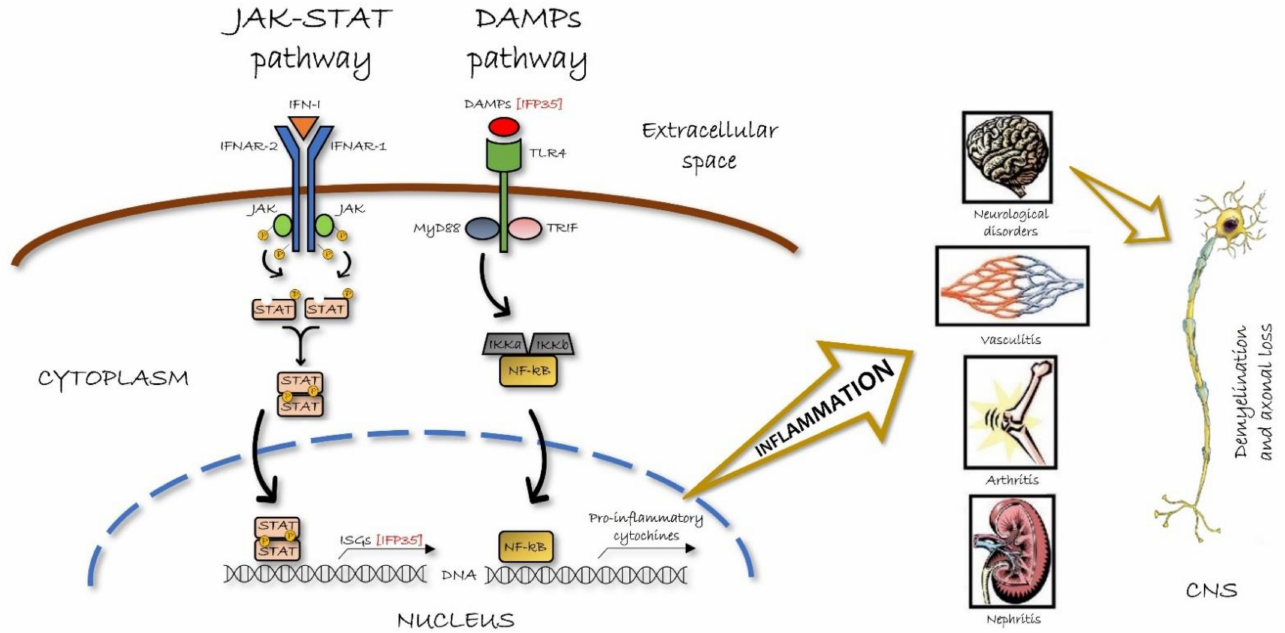
Figure 3. Mechanistic figure of JAK-STAT and DAMPs pathways involving IFP35. In the JAK-STAT pathway, the link between type I IFN molecule (IFN-I) and its receptor (IFNAR-1/IFNAR-2) induces the ligand-dependent dimerization of intracellular subunits, rapidly activating, in turn, the associated Janus kinase (JAK) by auto phosphorylation. Then, the activated dimer of signal transducer and activator of transcription (STAT) undergoes nuclear translocation, resulting in different interferon stimulated genes (ISGs) transcription, such as 35-kDa interferon-induced protein (IFP35). In the DAMPs pathway, the extracellular IFP35 serves as a damage associate molecular pattern (DAMP) molecule, recognized by Toll like receptor 4 (TLR4). The latter utilizes both molecular adaptors MyD88 and TIR domain-containing adaptor protein inducing interferon beta (TRIF) to activate nuclear factor kappa B (NF-kB) or interferon regulatory factor (IRF), respectively. While the IRF activation upregulates IFN genes resulting in the antiviral state, the MyD88 activation leads to an interaction between NF-kB and IkB kinases (IKK complex). Then, the activated NF-kB is translocated into the nucleus where it acts as a transcription factor of various pro-inflammatory cytokine genes. This results in a pro-inflammatory response based first on the innate immune activation, and then on the adaptive one. The immune response elicitation finally increases the inflammatory demyelination and axonal loss in the central nervous system (CNS) and tissue damage in the other organ-specific chronic inflammatory